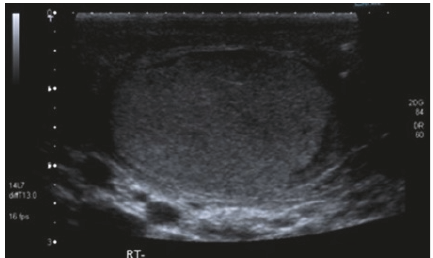
Figure 3: Follow-up ultrasound scan of right testis with a small amount of residual haematoma in scrotal sac.